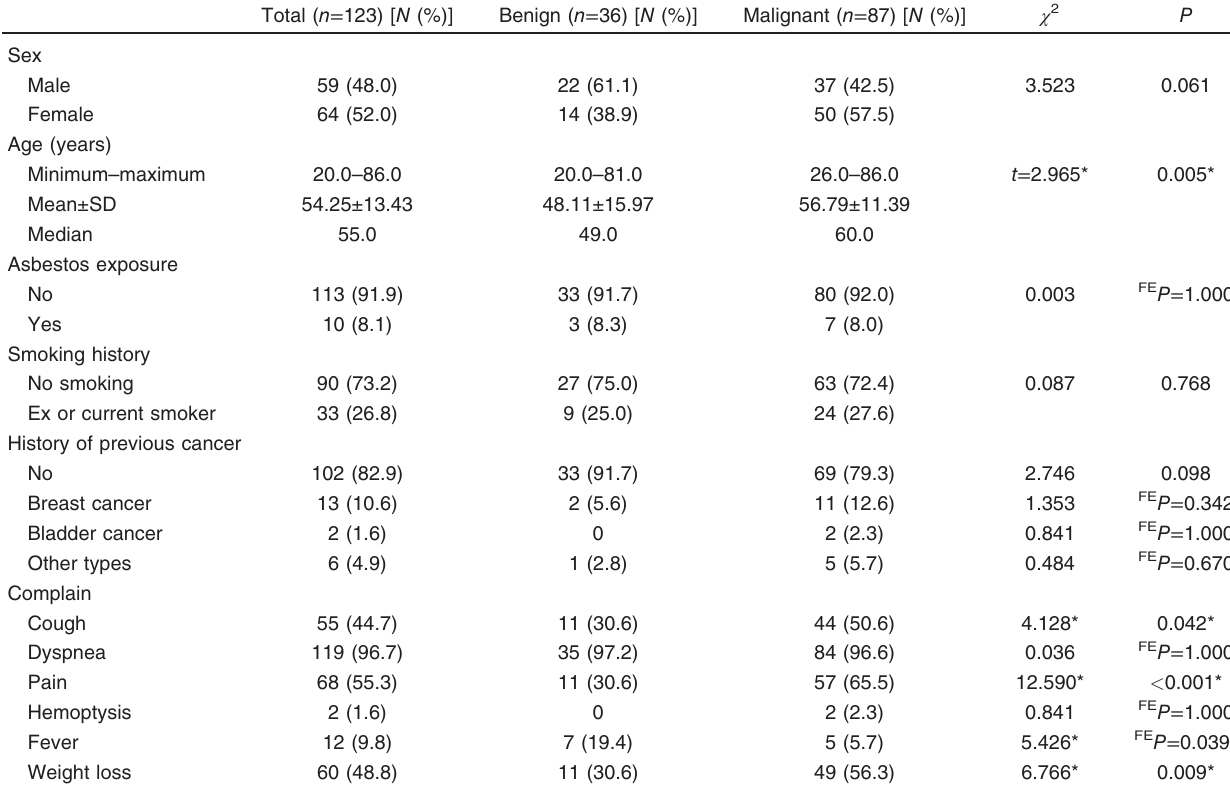
Table 2 Comparison between the two groups studied according to demographic and clinical data Total ( n = 123) [ N (%)] Benign ( n = 36) [ N (%)] Malignant ( n = 87) [ N (%)] χ